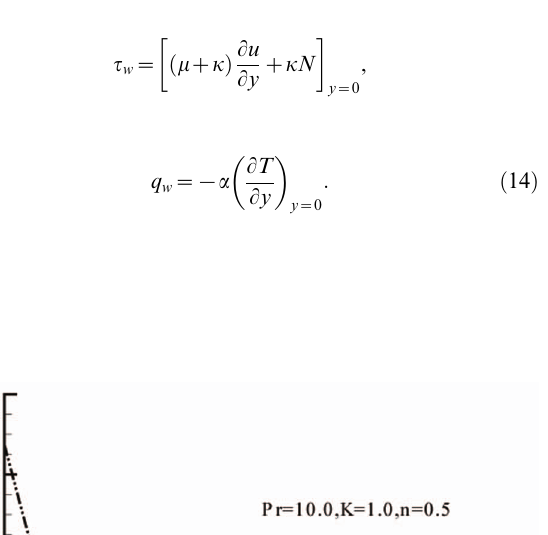
Table 2. Comparison of Re x